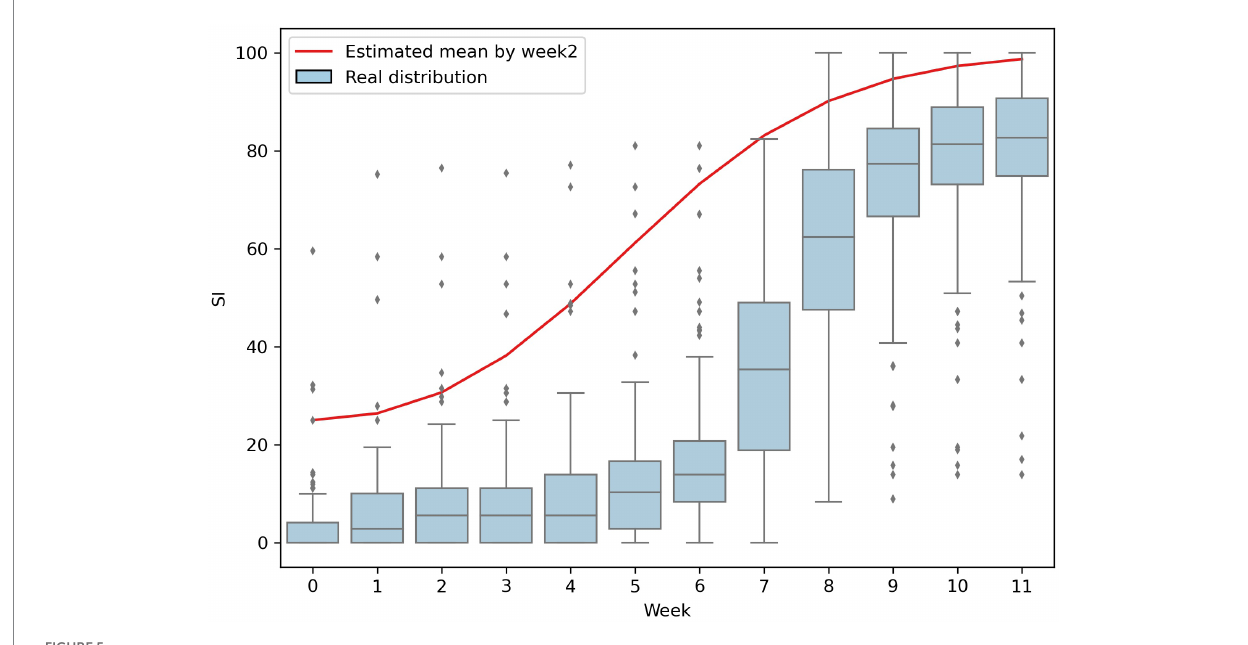
FIGURE 5 Comparing the estimated SI by only Week2 and the real distribution of SI.